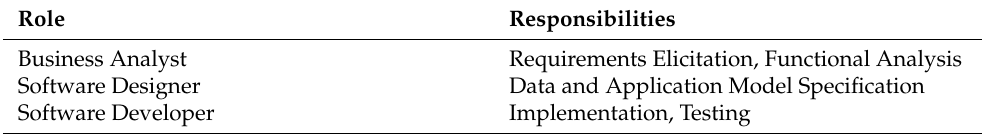
Table 1. Roles and